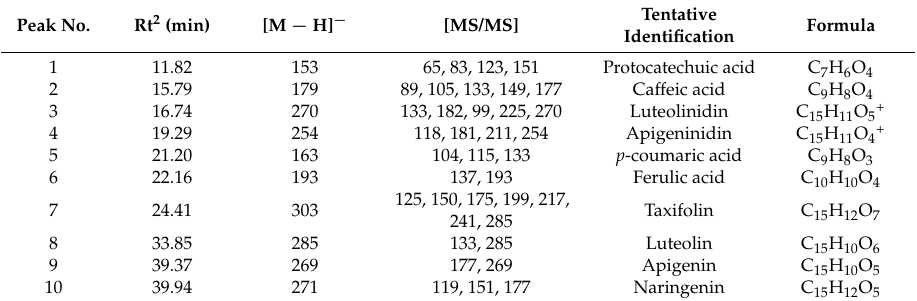
Table 4. Identification of phenolic compounds in sorghum grains 1 by RP-UHPLC-QTOF/MS 2 . Peak No.